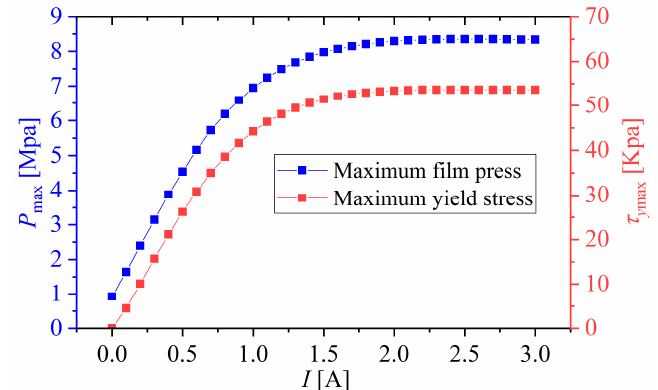
Figure 7. Maximum film pressure and yield stress varied with the current.